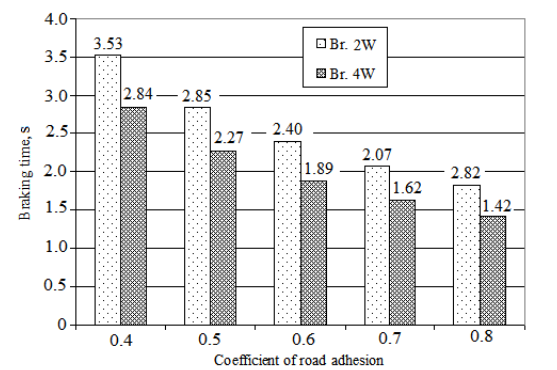
Figure 6. Variation of distance covered by the tractor during braking taking into account the time to a complete stop, for 5 val- ues of the coefficient of road adhesion - braking applied on rear axle wheels